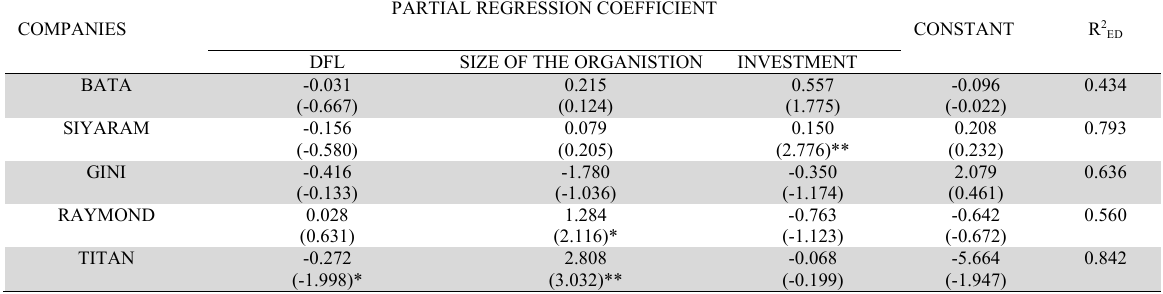
Analysis of Multiple Regression of Avg. Cash Holding on DFL, Size of Org. and Investment of the Selected Companies of retail